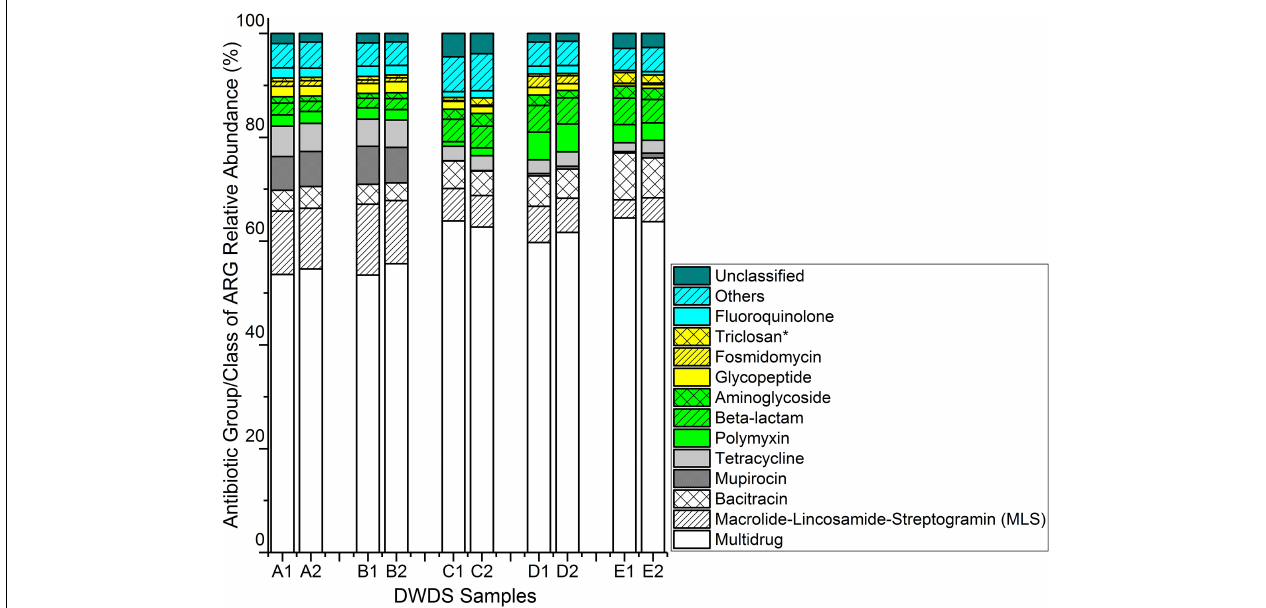
FIGURE 1 | Relative abundance of ARGs conferring resistance to different antibiotic classes/groups obtained from five drinking water distribution systems (DWDSs A–E) using high-throughput metagenome sequencing of total nucleic acids. *Triclosan is an antimicrobial agent, not an antibiotic. ARG having a relative abundance of less than two percent in all samples were grouped into “Others.” ARG types categorized as unclassified were the class/type of these ARGs were not identified with DeepARG.